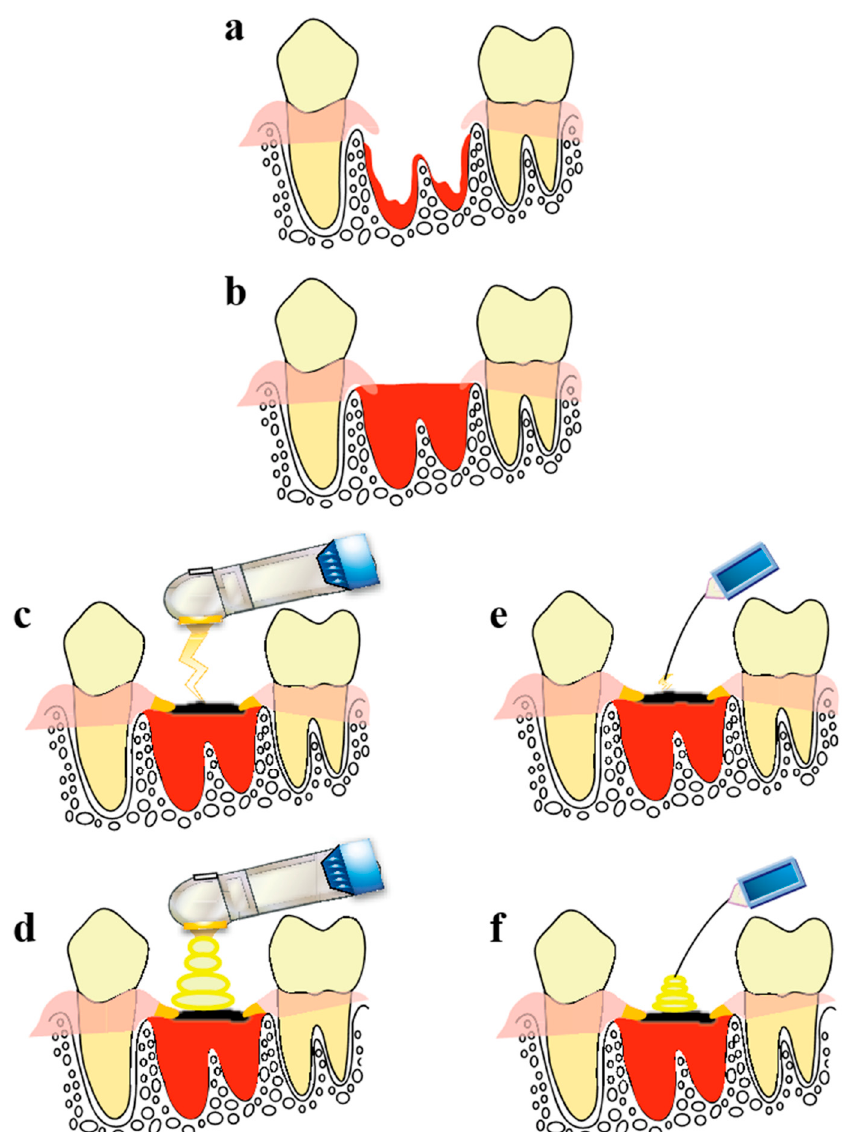
Figure 1. Laser treatment protocol. ( a ) Extraction site immediately after tooth extraction. ( b ) The inside of the tooth extraction socket was allowed to fill with an adequate amount of blood. ( c , e ) Carbonization of the blood in the superficial layer of the extraction socket with high-intensity laser therapy (HILT) to create an artificial eschar followed by fusion of the artificial eschar to the gingiva surrounding the extraction socket to prevent it from falling off. ( d , f ) Photobiomodulation therapy (PBMT) is performed the day after extraction to enhance healing. The procedure using the CO 2 laser is shown in ( c , d ), and the procedure using the diode laser is shown in ( e , f ). Reproduced from [12] under Creative Commons CC BY-NC 4.0.